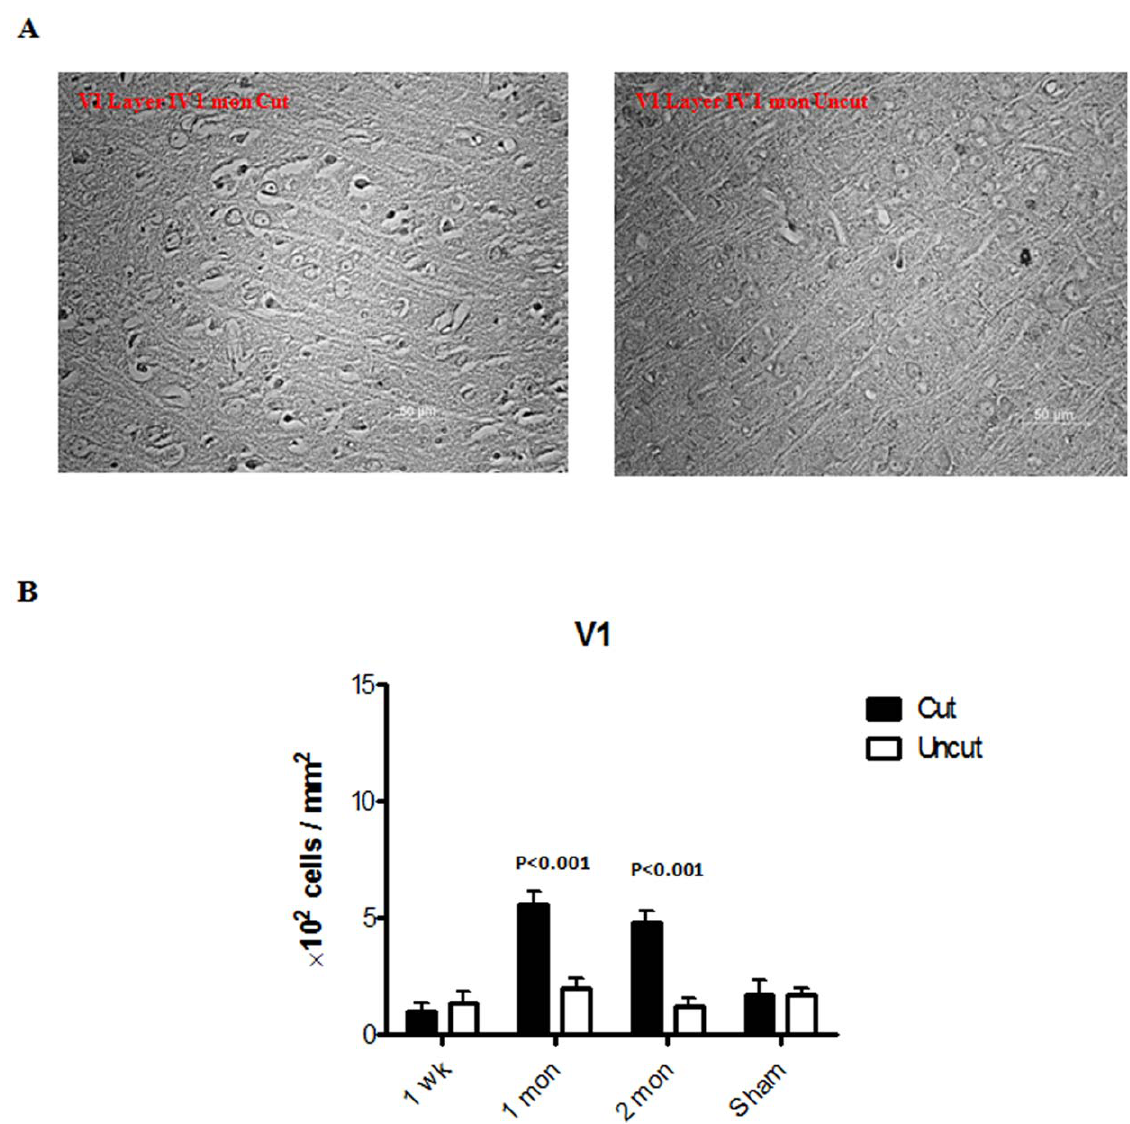
Figure 5. Apoptotic changes in V1. (A) Representative TUNEL staining of layer IV of V1 on month 1. (B) Density of TUNEL positive cells in layer IV of V1 from week 1 to month 2. (n=3 for each time point; n=2 for the sham control). Error bars represent